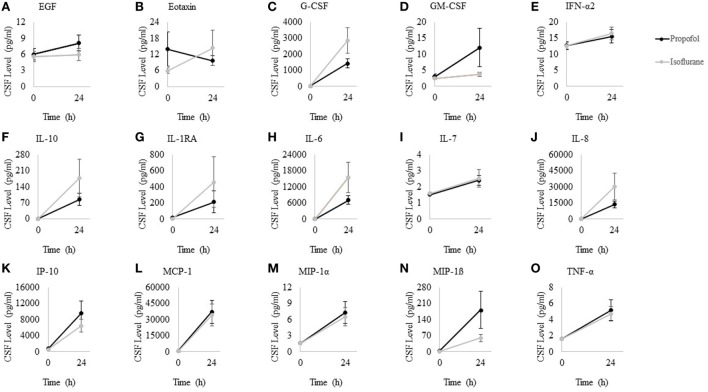
Cerebrospinal fluid (CSF) cytokine levels at 0 and 24 h after surgery for patients randomized to propofol and isoflurane. Wilcoxon rank sum tests showed that was no differences in cytokine levels between propofol and isoflurane-treated patients at either 0 or 24 h (p > 0.05 for all, prior to Bonferroni correction). Data points represent anesthetic group means; error bars represent standard error of the mean. (A) EGF, (B) Eotaxin, (C) G-CSF, (D) GM-CSF, (E) IFN-α2, (F) IL-10, (G) IL-1RA, (H) IL-6, (I) IL-7, (J) IL-8, (K) IP-10, (L) MCP-1, (M) MIP-1α, (N) MIP-1β, and (O) TNF-α.